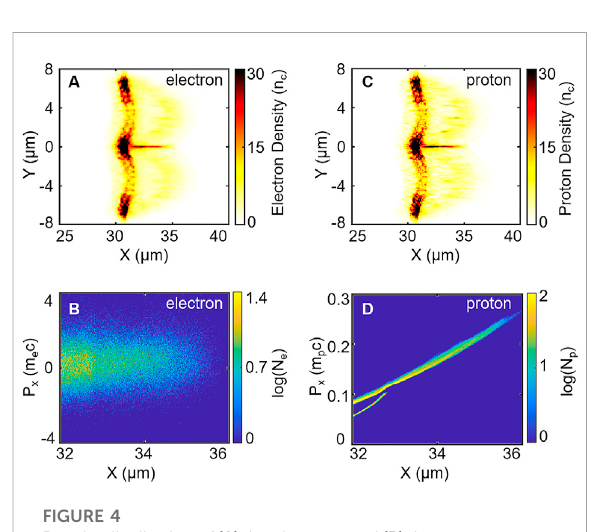
FIGURE 4 Density distribution of (A) the electrons and (B) theprotons at t = 80TL. Phase spaces of (C) the electrons and (D) protons in the region (r ≤ 0.2 μ m, 32 μ m < × < 34 μ